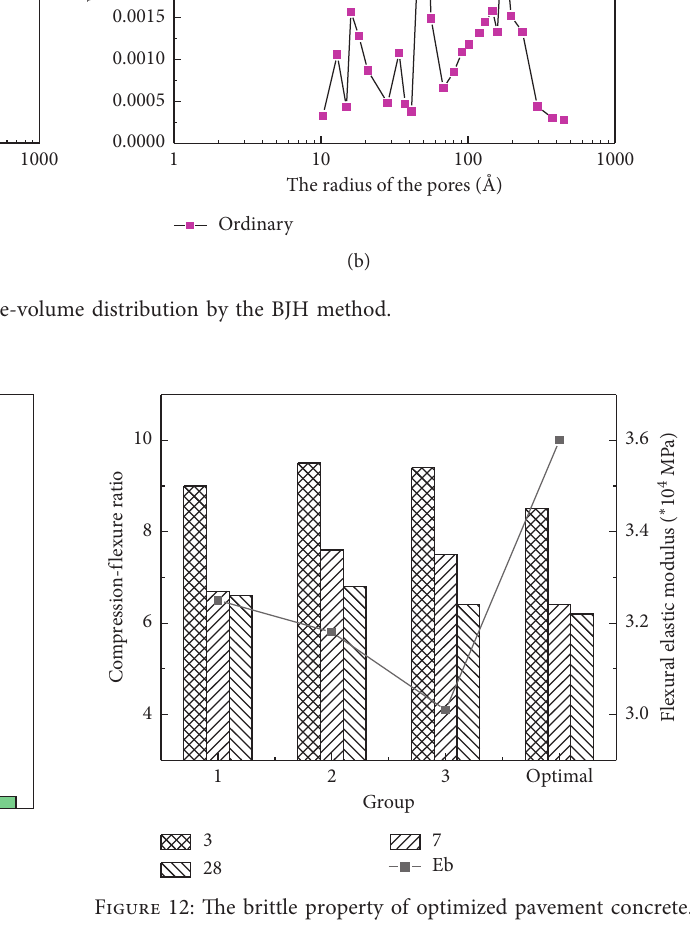
Figure 11: The results of pore-size distribution.